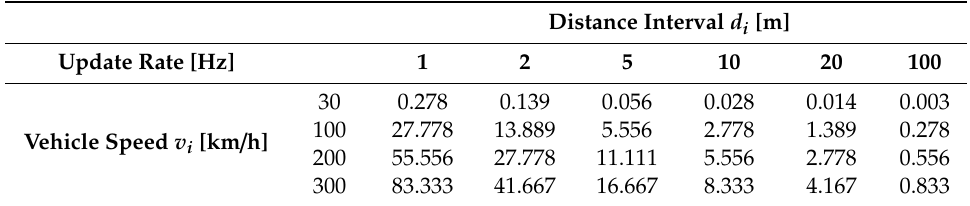
Table 1. Distance interval between two consecutive measurements made by the Global Navigation Satellite System (GNSS) receiver as function of the GNSS update rate and the vehicle